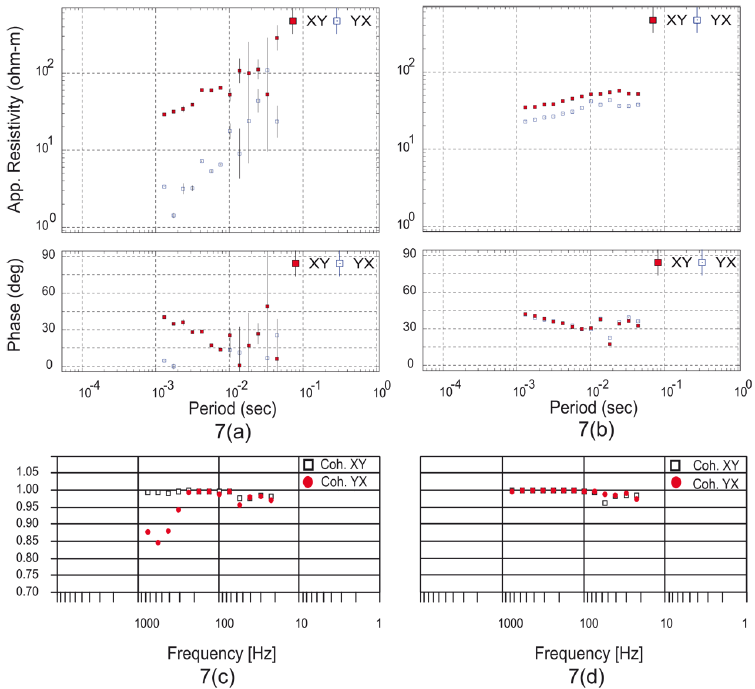
Figure 7. Influence of FIR (Finite Impulse Response) notch filter on data with 4096 Hz sampling frequency of site K11 from Koyna profile. The filter length applied here is 16,385 (with N = 4; 4 × 4096 + 1) and the filter bandwidth is 10Hz with lower and upper cut off frequencies 45 Hz and 55 Hz ( D f = 10 Hz = 55 Hz − 45 Hz) to suppress the power line frequency at 50 Hz. (a) Apparent resistivity (top panel) and phase (bottom panel) curves obtained from the data before notch filtering. (b) Apparent resistivity (upper panel) and phase (lower panel) curves of the same data obtained after notch filtering showing a improved result. The red colored boxes represent XY components and the blue colored boxes represent YX components of apparent resistivity an phase. The effectiveness of the notch filter can be realised from the coherency plots. (c) Coherency plot of the same data set before notch filtering. (d) Coherency plot after notch filtering shows an improvement in coherency of the components. Here boxes represent the coherency of XY components and the red circles represents the coherency of YX